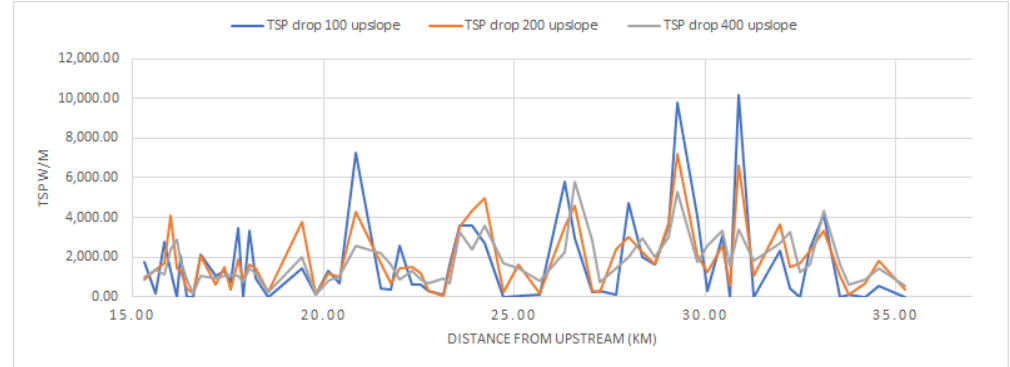
Figure 9. Linear representation for the stream power values along the reach of the Topino